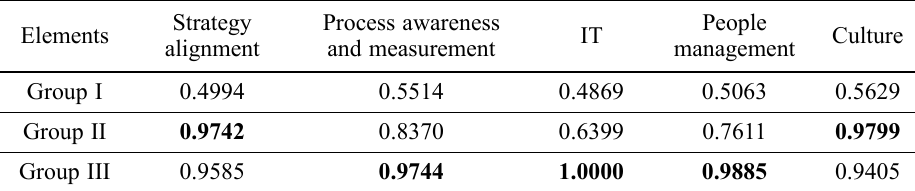
Table 2. Priority vectors for BPMM elements